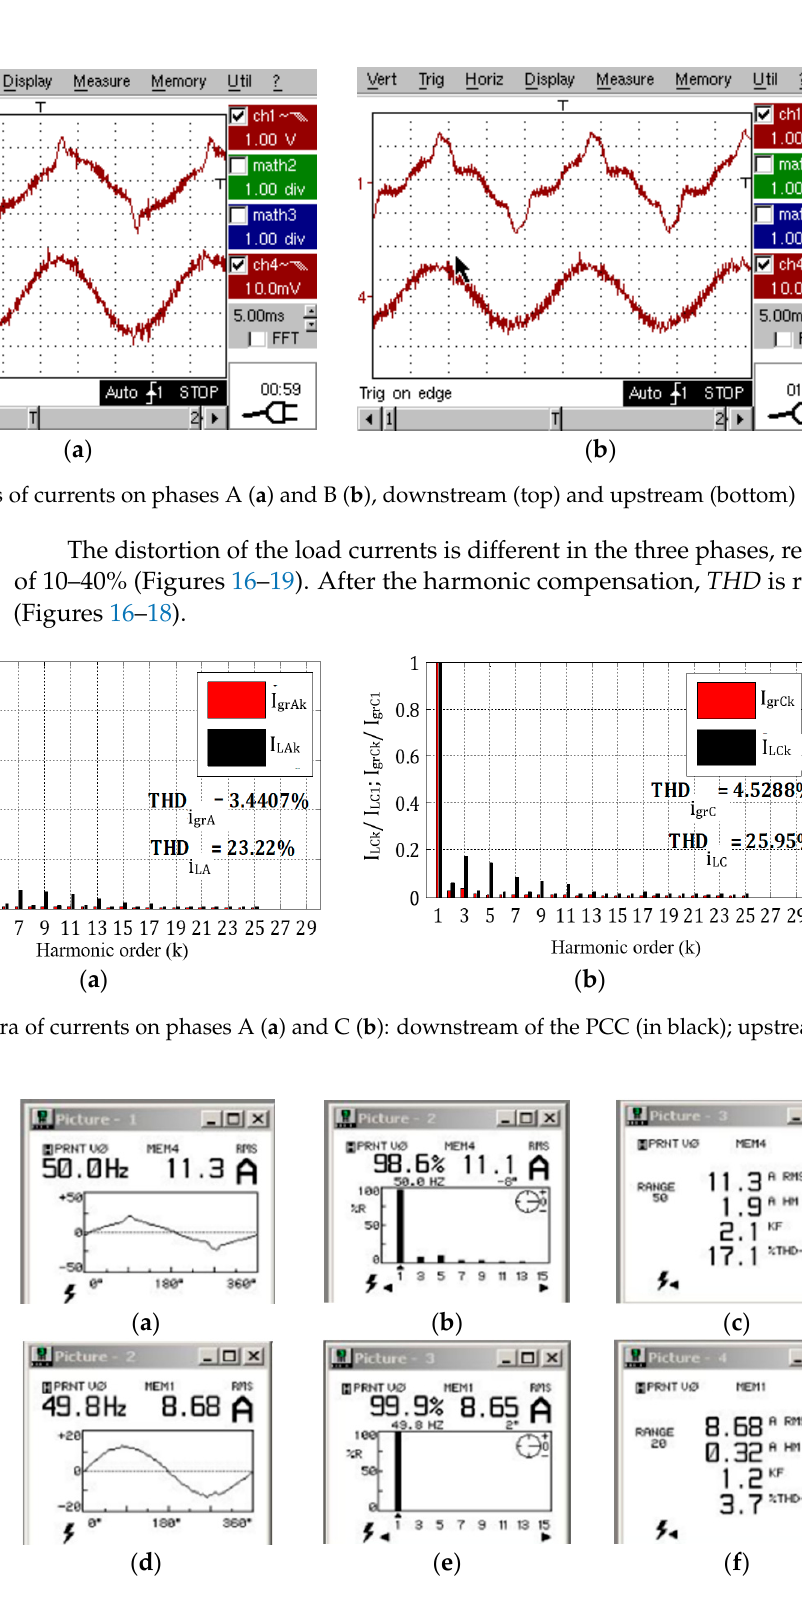
Figure 17. Waveform, harmonic spectrum and THD of the current on phase A: downstream of the PCC ( a – c ); upstream of the PCC ( d – f ).